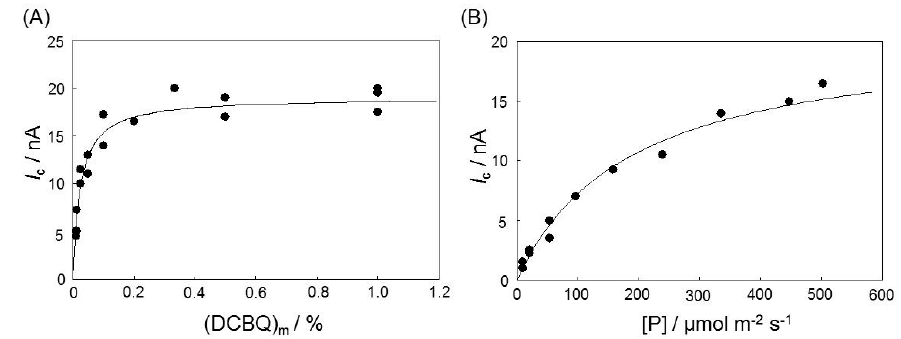
Figure 2. Dependence of the amount of DCBQ embedded in the CPE ( A ) or the photon flux intensity ( B ) on the photocurrent ( I c ). Lines represent the regression curves as determined using Equation